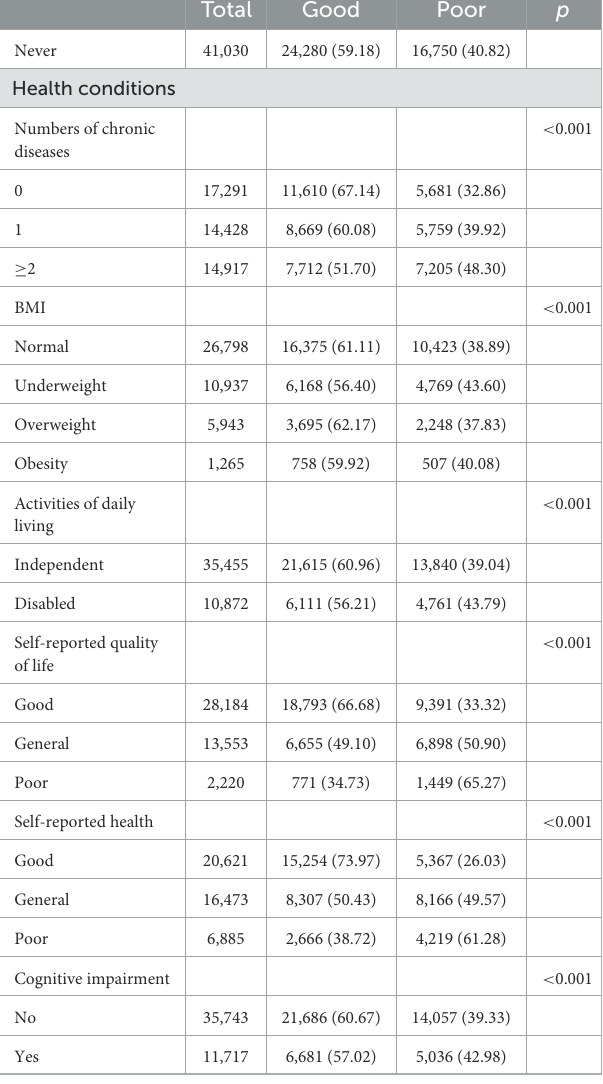
for continuous variables. We tested statistical differences using the chi-square test for categorical variables and the t -test for normally distributed continuous variables according to sleep quality and sleep duration. We used multivariate logistic regression models to analyze risk factors related to poor sleep quality, short sleep duration, and long sleep duration by calculating the odds ratio (OR) with 95% confidence interval (CI). In the sensitivity analysis, we further divided the participants into three groups ( < 7, 7–9, > 9 h) to assess factors associated with sleep duration < 7h and more than 9 h. Moreover, we in the multivariate logistic regression models to examine the robust of the results in the sensitivity analysis. All the analyses were performed with IBM SPSS 26.0 (IBM